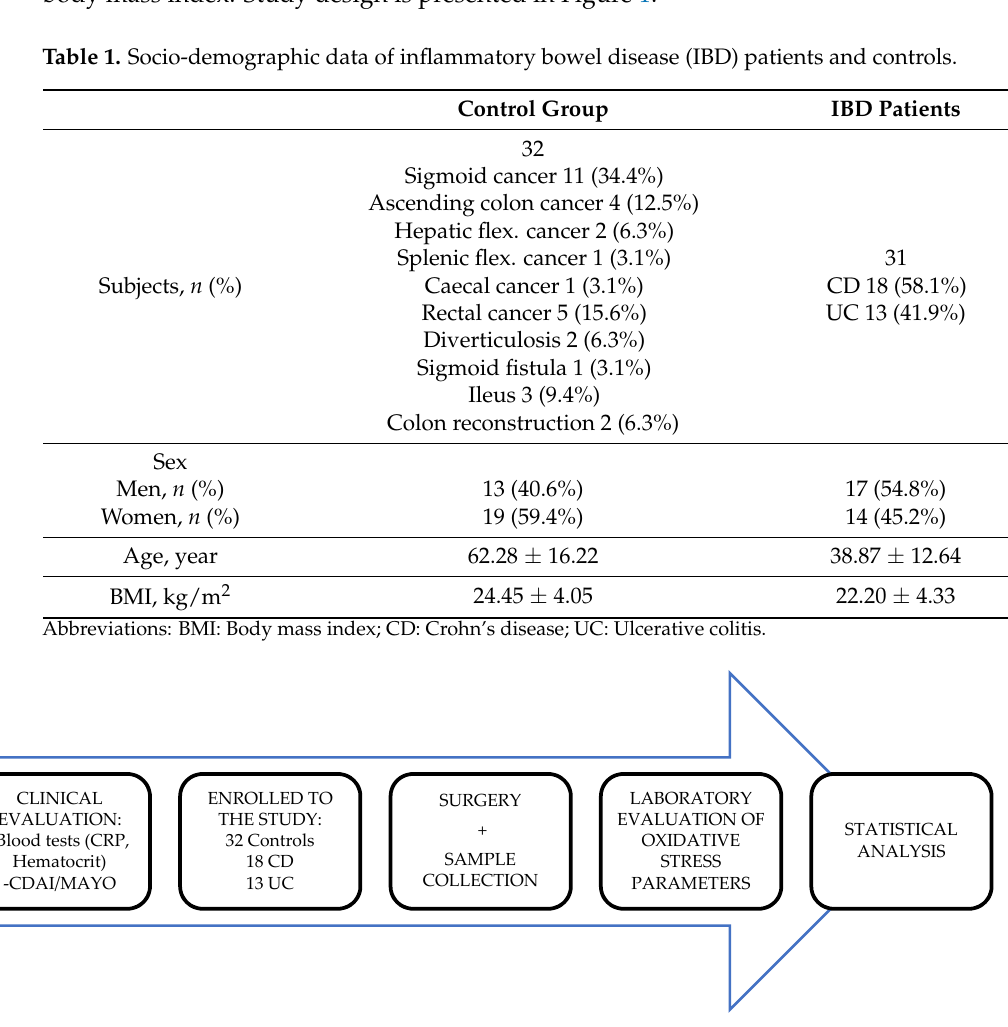
Figure 1. Study design. Figure 1. Study Table 1. Socio-demographic data of inflammatory bowel disease (IBD) patients and controls.